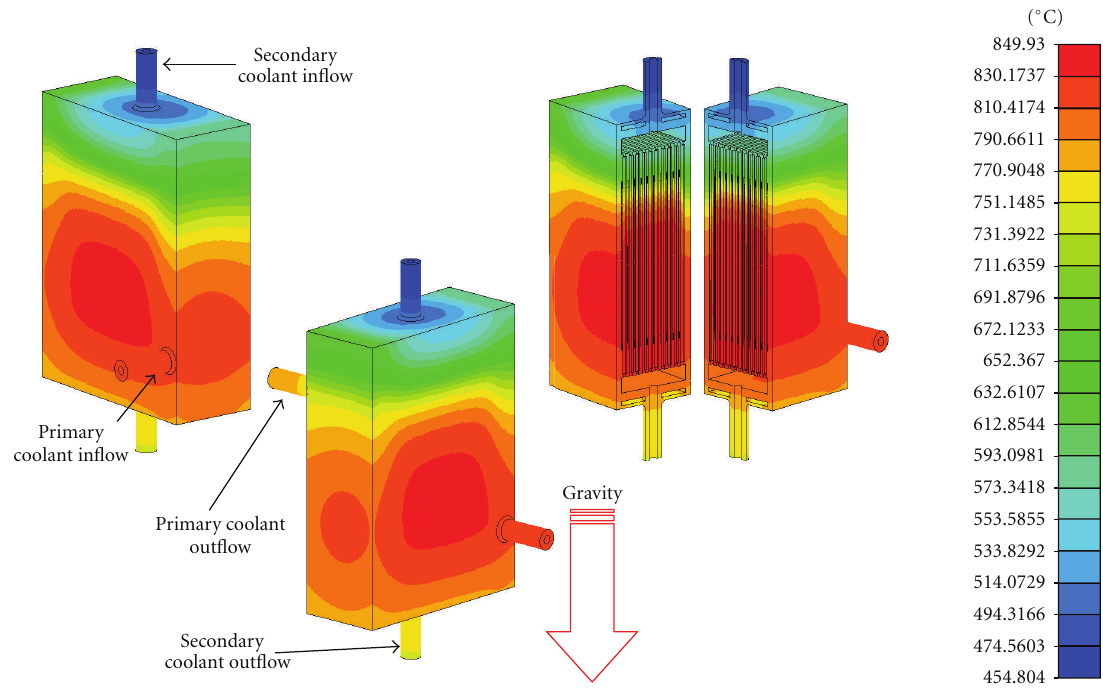
Figure 10: Temperature contour of the PHE outside